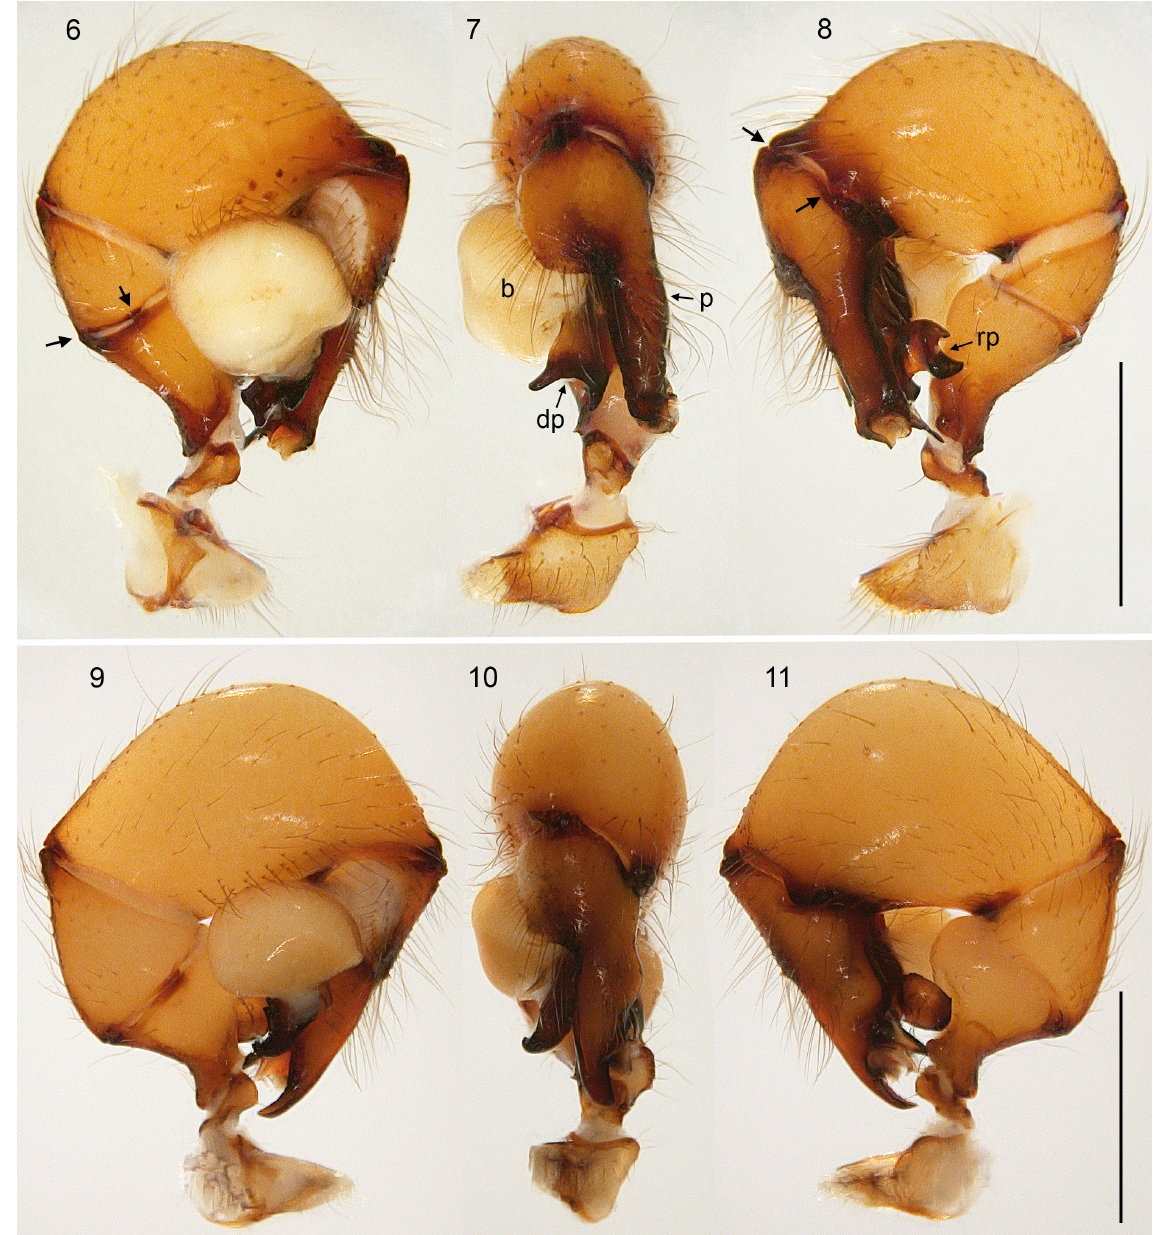
Figs 6–11. Stygopholcus Kratochvíl, 1932; left male pedipalps, prolateral, dorsal, and retrolateral views. 6–8 . S. skotophilus Kratochvíl, 1940; from Ilijina pećina, Bosnia and Herzegovina (ZFMK (Ar 22198)). 9–11 . S. photophilus Senglet, 1971; from Episkopi, Crete (ZFMK (Ar 22205)). Abbreviations: b = genital bulb; dp = dorsal process (of genital bulb); p = procursus; rp = retrolateral process (of genital bulb). Arrows point at joints shifted toward prolateral (femur-patella) and retrolateral (tibia-tarsus). Scale bars: 1